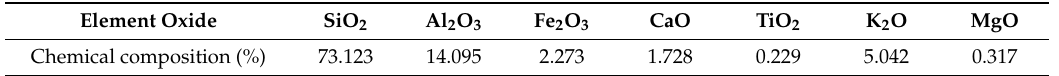
Table 1. Chemical elemental contents in silicate tailing.